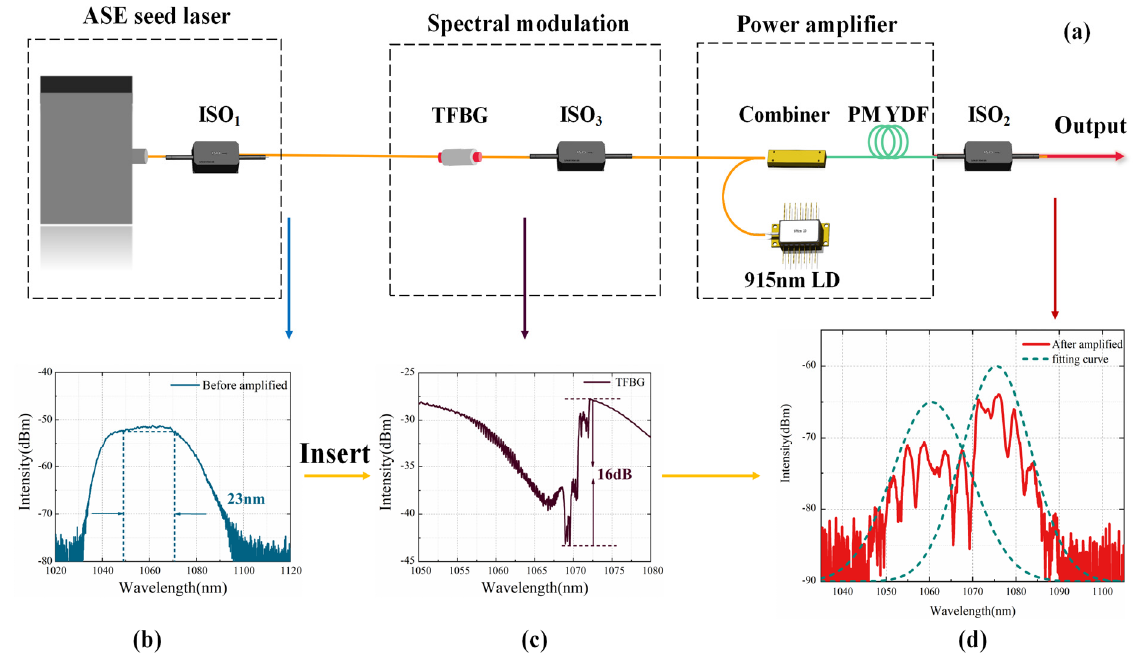
Figure 2. ( a ) Experimental setup of the double-peaked pump source. ( b ) The spectrum of the ASE seed source. ( c ) The TFBG transmission spectrum. ( d ) The pump source spectrum after power am- plification.